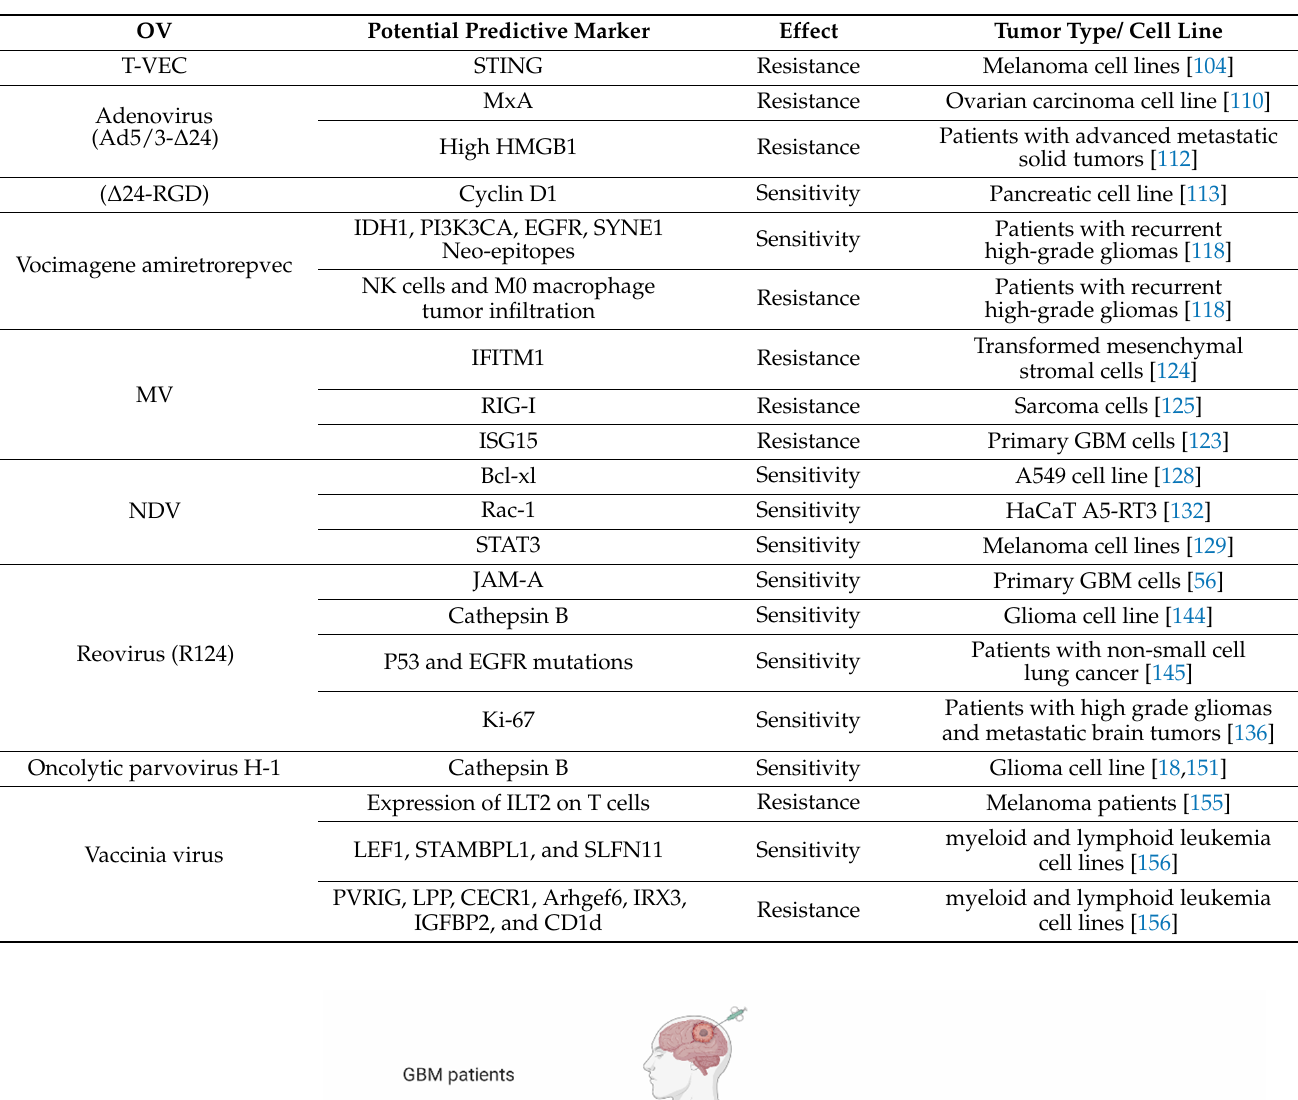
Table 2. Potential predictive markers for sensitivity or resistance to OVs.